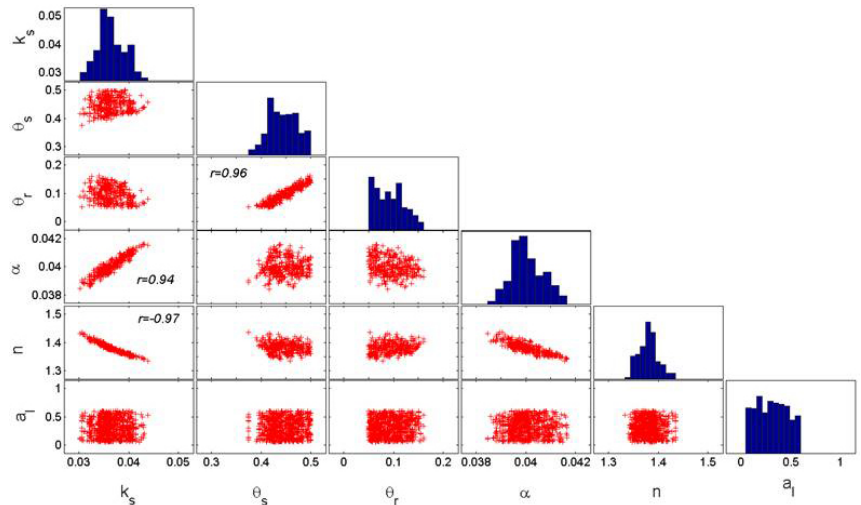
Figure 2. MCMC solutions for the transport scenario 1. The diagonal plots represent the inferred posterior probability distribution of the model parameters. The off-diagonal scatterplots represent the pairwise correlations in the MCMC drawing.